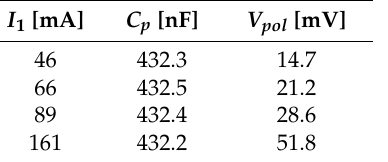
Figure 6. The simulated I-V characteristic obtained with the L 1 as variable load.